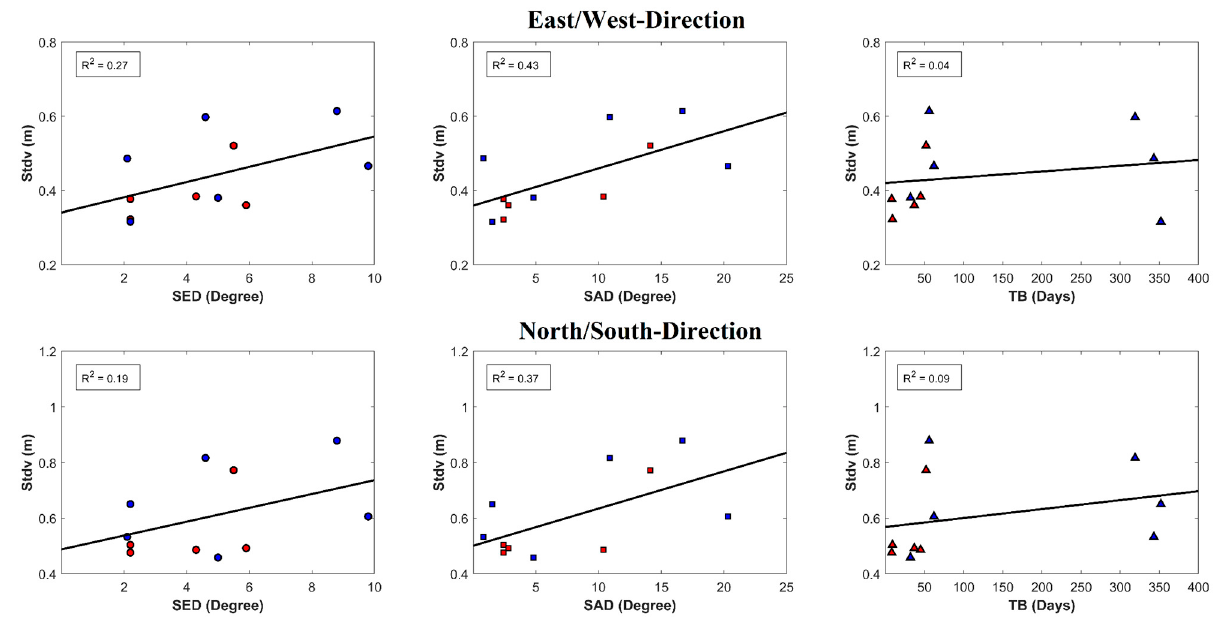
Figure 9. Relationship between the SED, SAD, TB, and uncertainties in the East/West direction ( top ) and North/South direction ( bottom ) after imposing a limitation to SED and SAD (SED ≤ 10 ◦ and SAD ≤ 20 ◦ ). The red and blue colour indicate the first and second time series POT results, respectively. The circle, square, and triangle markers represent the SED, SAD, and TB, respectively. The black lines represent the best linear fits.